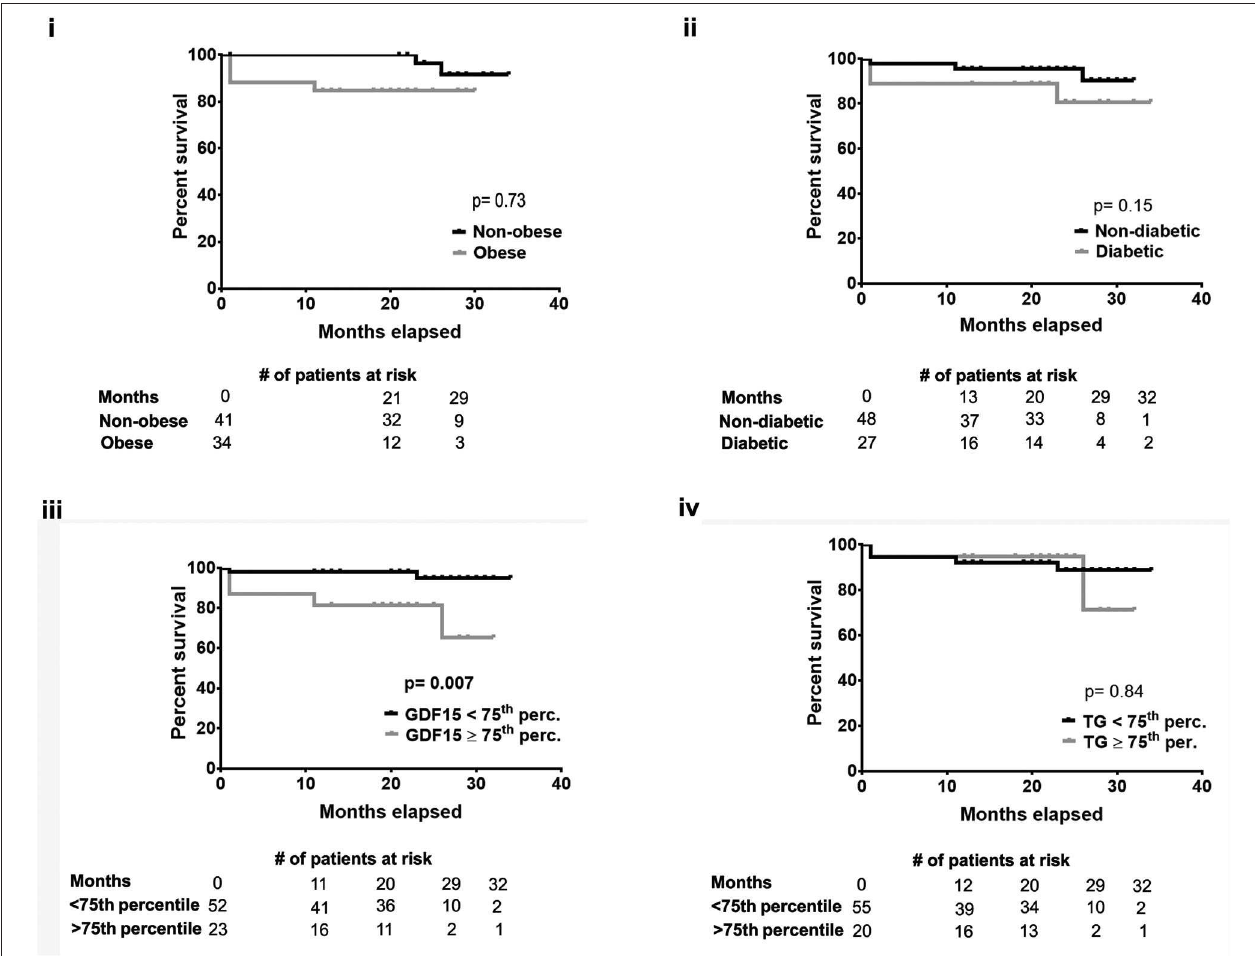
FIGURE 3 | Patients with GDF15 ≥ 75th percentile had a significantly worse prognosis. Using Kaplan Meier curves, followed by Log-Rank test, there was no significant difference in 2 year post-surgery survival between patients who were (i) non-obese/obese (ii) non-diabetic/diabetic (iv) or TG < 75th percentile/ ≥ 75th percentile. However, patients with plasma GDF15 ≥ 75th percentile had a significantly poor post-surgery outcome compared to those with GDF15 < 75th percentile (iii)